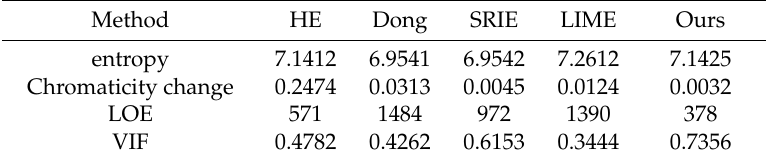
Table 3. Objective evaluation index of different algorithms for real low-light